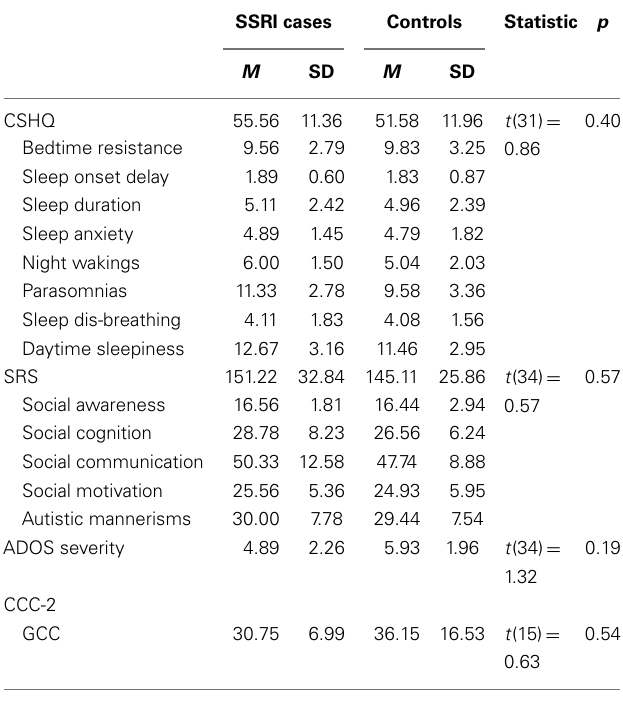
Table 2 | Study 1: descriptive statistics and independent-samples t -tests for CSHQ, SRS, andADOS severity scores.